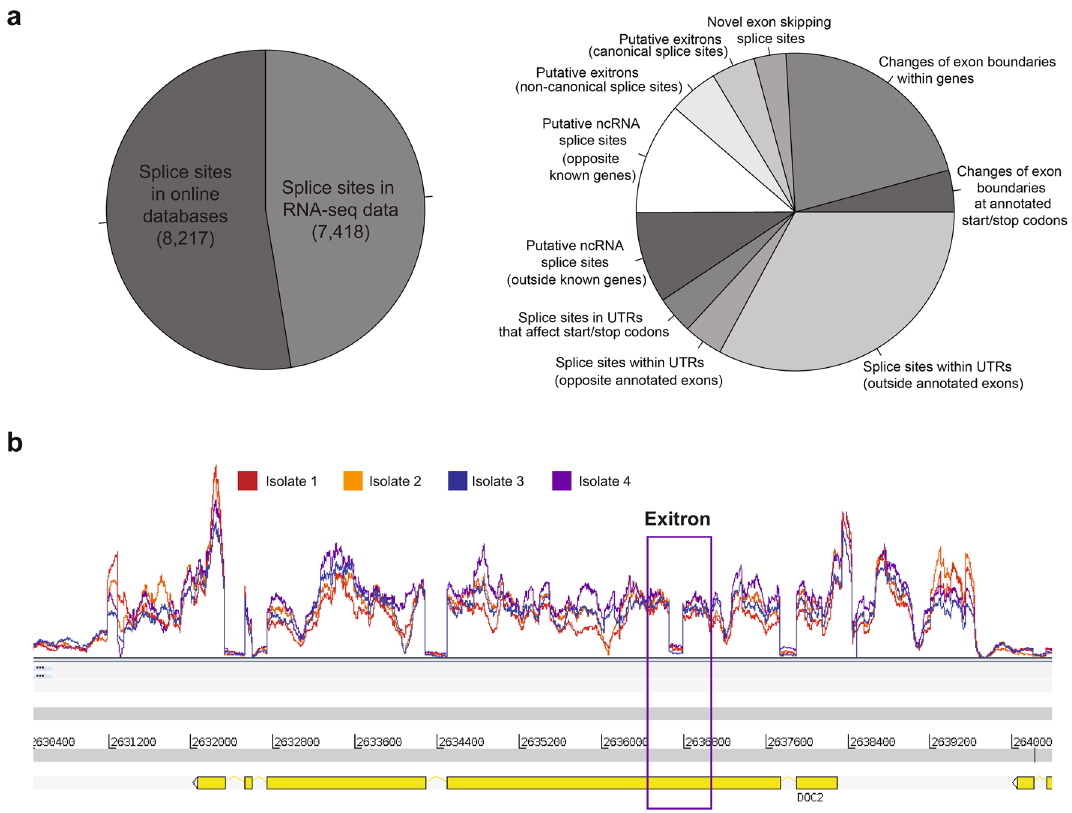
Figure 2. Splice sites present in P. vivax schizonts. ( a ) Thousands of splice sites were detected in the RNA-seq data (left), with splice sites not found in online databases (right) falling into a range of categories for both